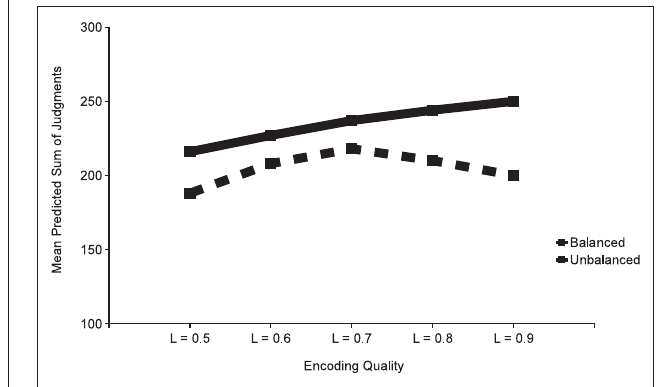
FiGure 2 | Mean predicted sum of probability judgments as a function of encoding quality for balanced and unbalanced distributions for the HyGene